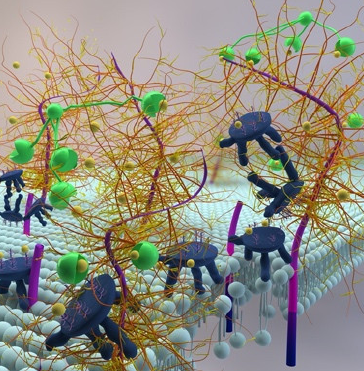
Figure 4. Conceptual model of CLU protection and sealing of the damaged ocular surface. Damage to the mucosal glycocalyx due to proteolysis and denaturation and damage to the plasma membrane due to oxidation is sealed by CLU via solubilization and lipid bilayer intercalation. The blue “stools” represent CLU molecules. The gold “brushes” represent membrane-associated mucins. The green “mouths” represent LGALS3 multimers. The light blue “hairpins” represent the lipid bilayer. (updated from (56)).